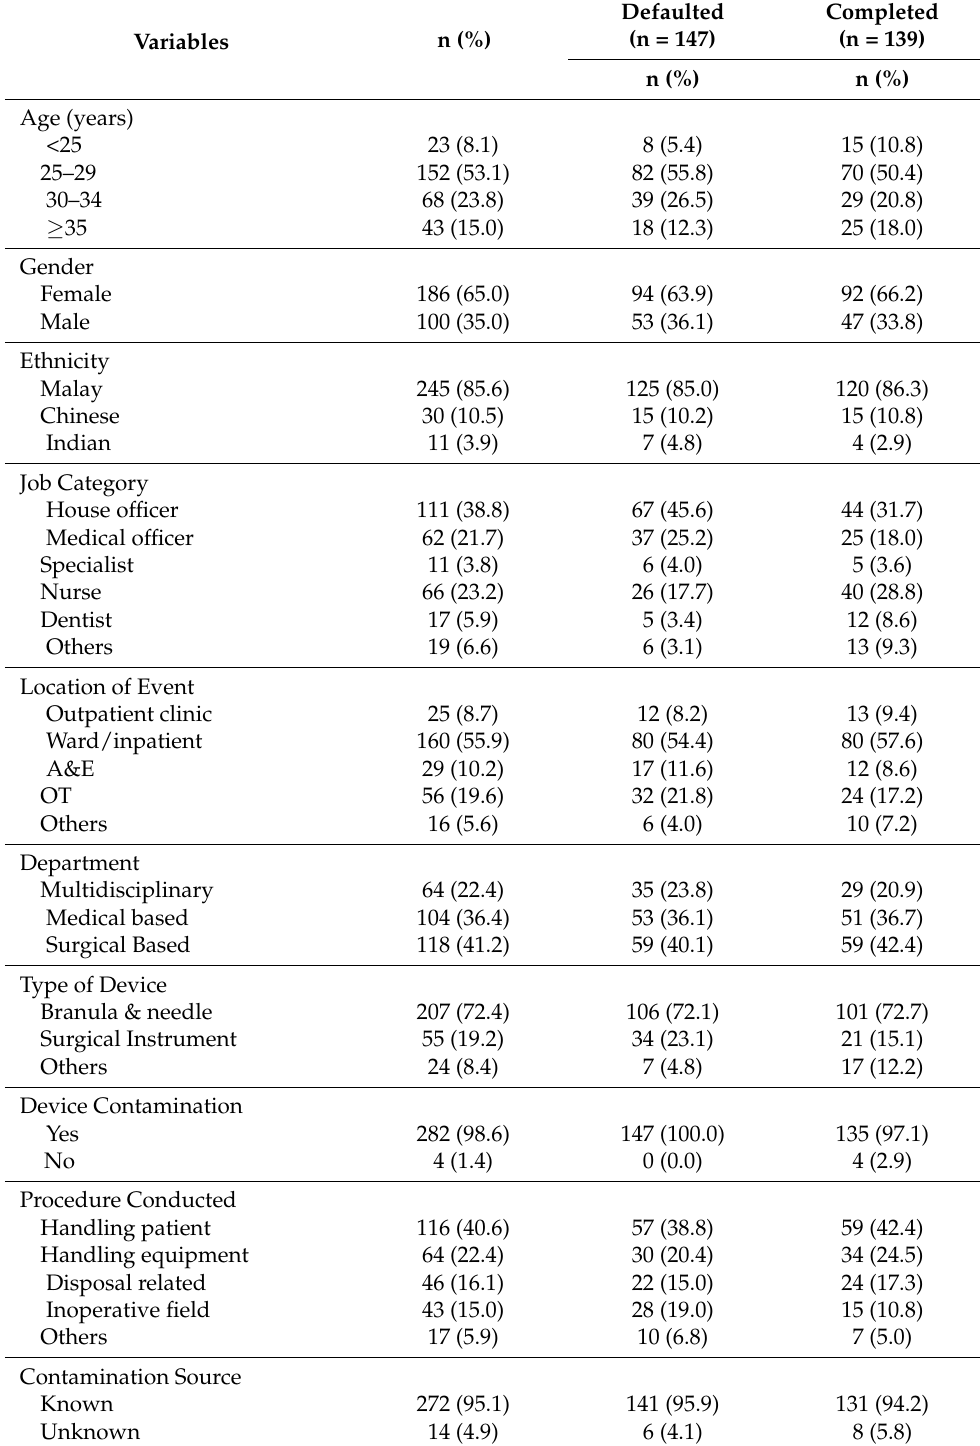
Table 1. Characteristics of sharp injury cases among HCWs in Hospital USM and follow up distribu- tion (n =